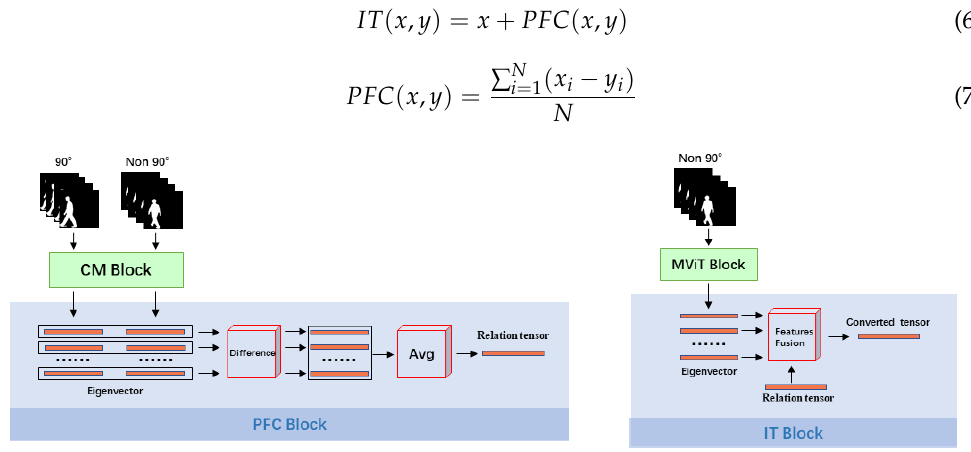
Figure 3. PFC block and IT block.